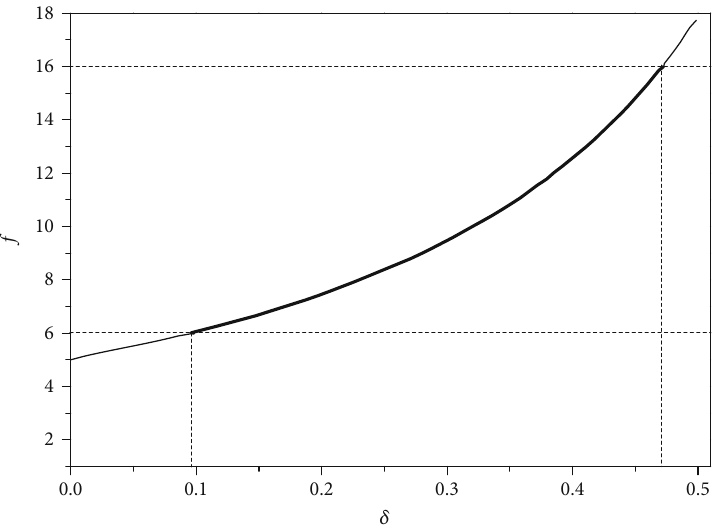
Figure 5: Criterion values for di ff erent de fl ection-thickness